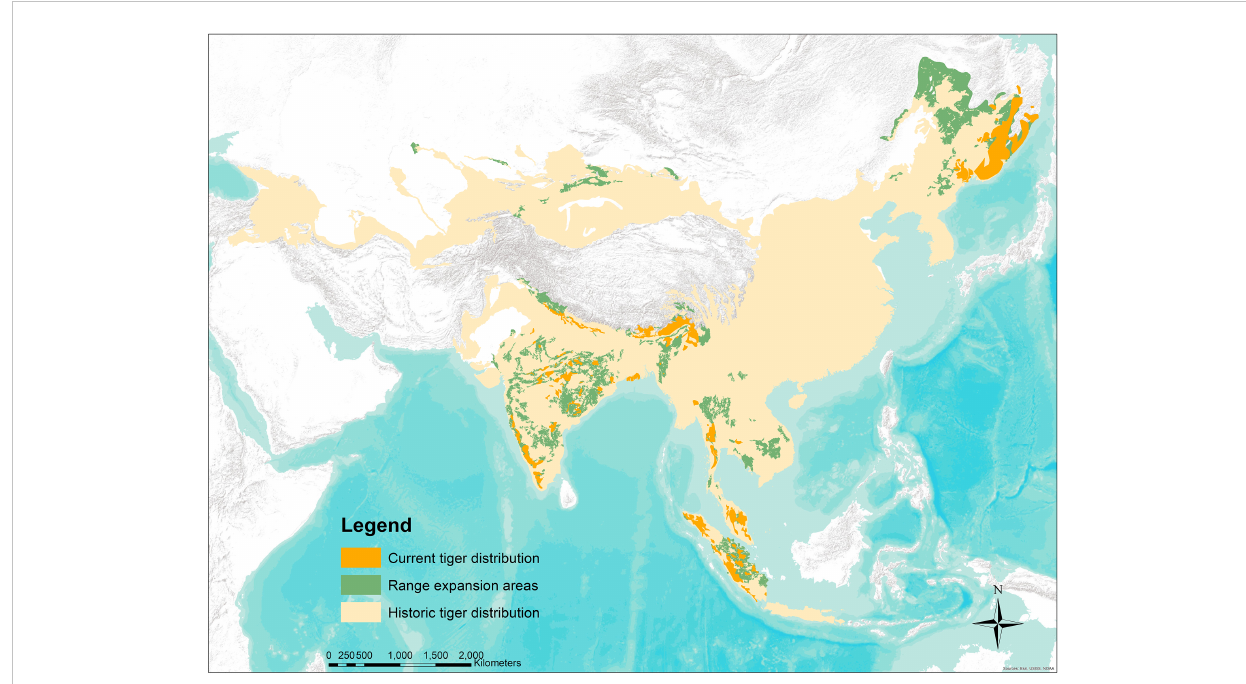
FIGURE 1 Historic and current tiger distribution and range expansion areas. Historic tiger distribution (as described in the text), current tiger distribution from Goodrich et al. (2015) amended per text. Tiger range expansion (1,293,921-km 2 ) per our analysis.